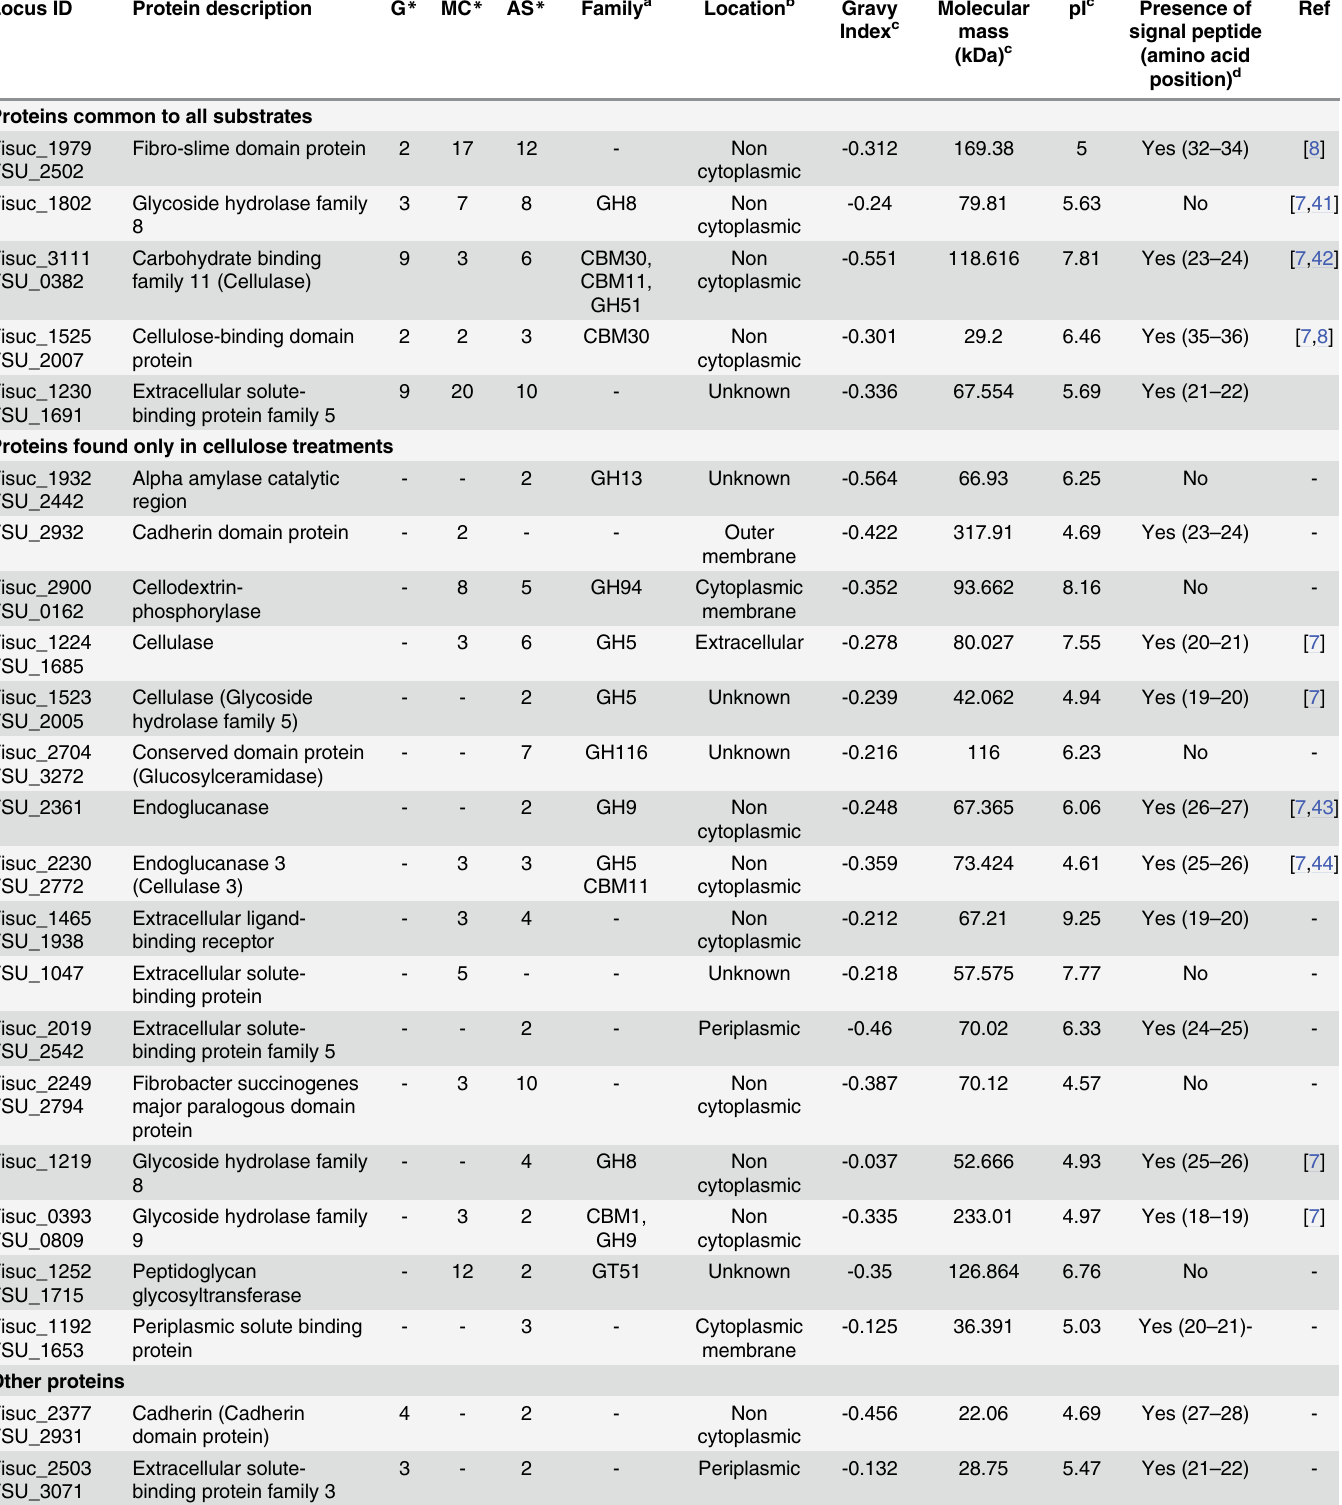
Table 1. List of predicted cell envelope proteins associated with cellulose degradation in F . succinogenes S85. Locus